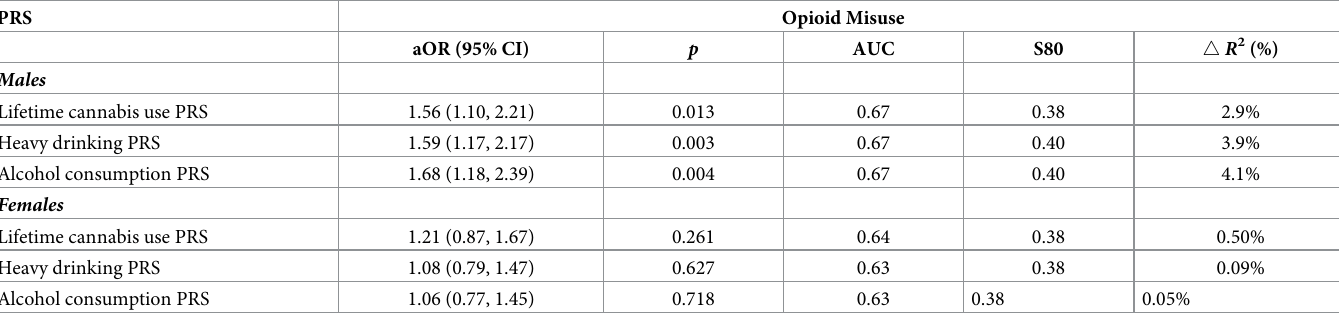
Note. Intervention status, cohort, and 10 ancestry-specific principal components were included as covariates. AUC = area under the curve; S80 = sensitivity corresponding to 80%